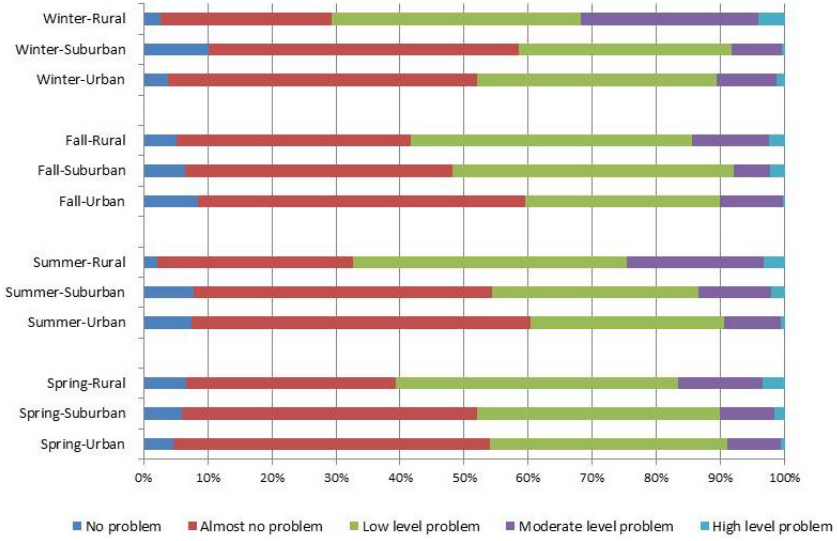
Figure 4. Distribution of the HBS stratified by residency regions.